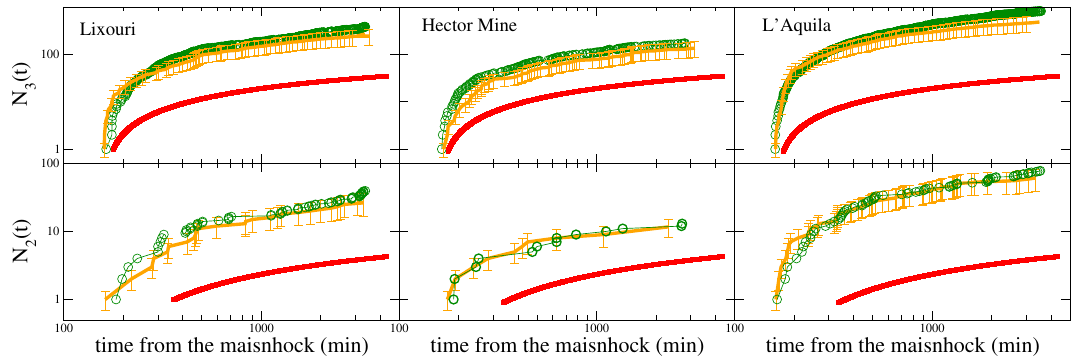
Figure 11. The quantities N 3 ( t ) ( top ) and N 2 ( t ) ( bottom ) are plotted for t − t 0 > T 2 = 160 min as green circles for the three main-aftershock sequences of Figure 1: the 26 January 2014 m = 6.1 Lixouri earthquake ( left ), the 16 October 1999 m = 7.1 Hector Mine earthquake ( middle ) and the 6 April 2009 m = 5.9 L’Aquila earthquake ( right ). Red squares are the expected values according to Equation (6) using the average values obtained in Reference [55]. The orange curves are the expected values using in Equation (6) the best parameters K and c inverted from the experimental fit of τ , φ and ∆ µ . The error bars in each plot incorporate both the uncertainty in the estimate of ( ∆ µ , φ ) and fluctuations in the aftershock number for given values of K and c . From Reference